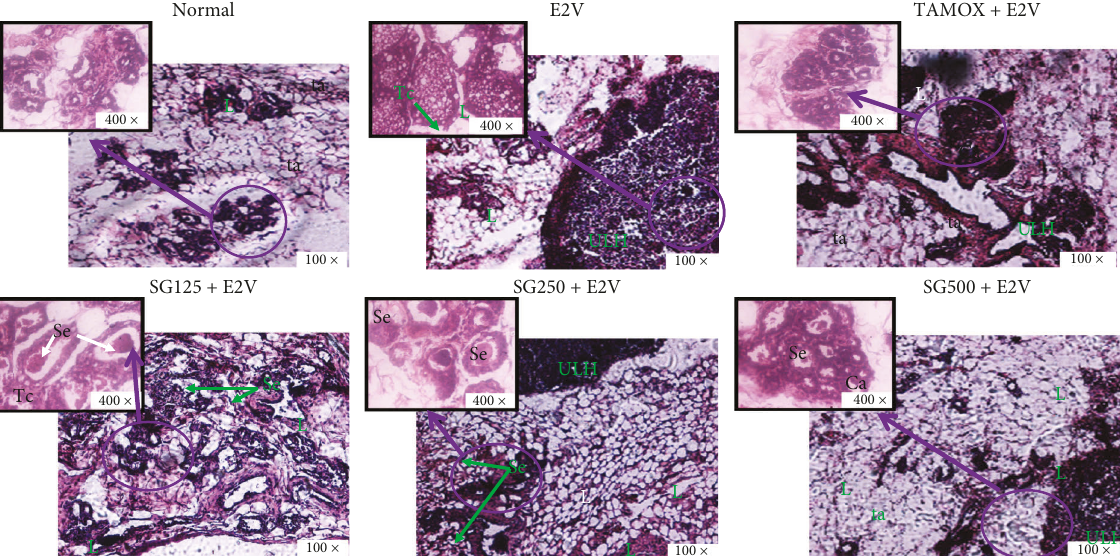
Figure 3: Effects of S. gilo hydroethanolic extract on microphotographs H&E 100 × and 400 × of mammary glands after 16 weeks of treatment. NOR � Normal control treated with distilled water; E2V � E2V-control treated with distilled water; SG+E2V � Animals treated with the S. gilo hydroethanolic extract at the doses of 125, 250, and 500mg/kg BW. TAMOX+E2V � Animals treated with tamoxifen (3.3mg/kg BW); all groups except the normal group (NOR) received chronic administration of E2V at the dose of 1 mg/kg BW. La � lumen of alveoli; At � adipose tissue; Se � eosinophil secretion, L � lobular; HLU � hyperplastic lobular